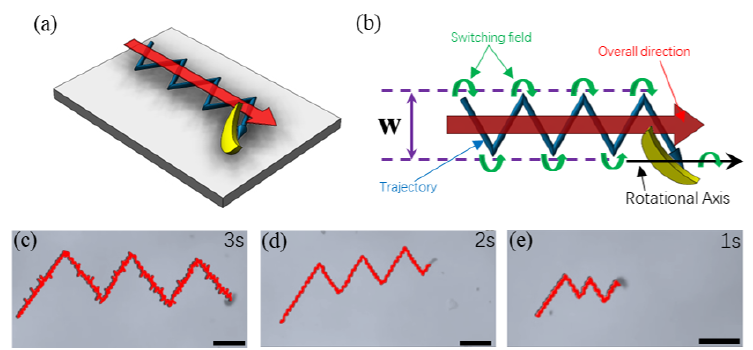
Figure 7. ( a ) Schematic of the zigzag trajectory strategy of a C1 microswimmer achieving overall forward swimming; ( b ) Schematic of the zigzag trajectory achieved by switching the field direction; ( c , d ) Zigzag trajectories achieved by a C1 microswimmer with different switching intervals of the magnetic field. Scale bars: 100 µ m. ( c ) 3 s interval. ( d ) 2 s interval. ( e ) 1 s